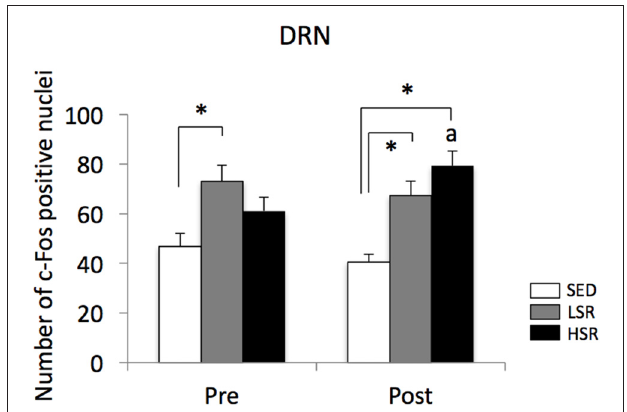
FIGURE 4 | Mean ( ± SEM) numbers of c-Fos positive nuclei in the PVN of rats after acute treadmill running at different intensities in the pre- and post-training. SED, sedentary controls; LSR, low-speed runners; HSR, high-speed runners. a p < 0.05 vs. the pre-training